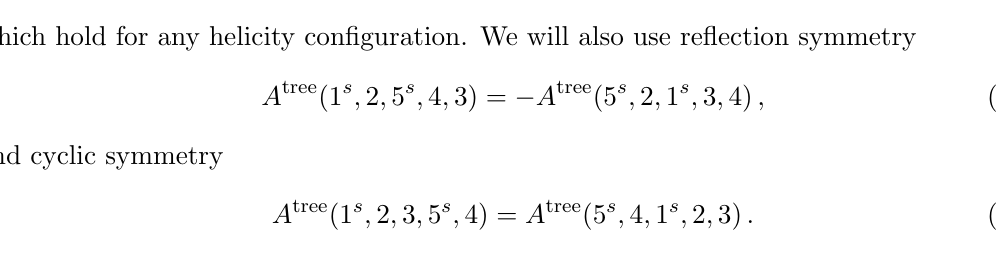
Figure 31 . The four-point cubic diagram whose numerator (B.7) determines all other diagram